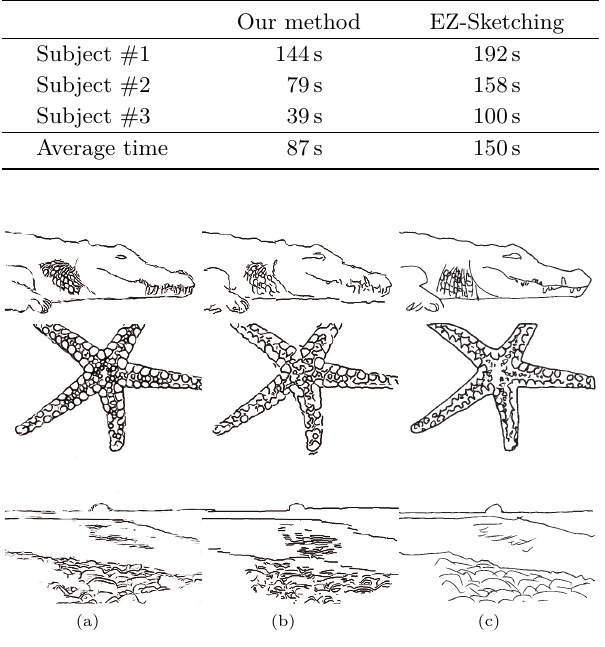
Fig. 13 Results generated by different systems. (a) Reference line drawings. (b) Line drawing generated by our system. (c) Line drawing generated by EZ-Sketching